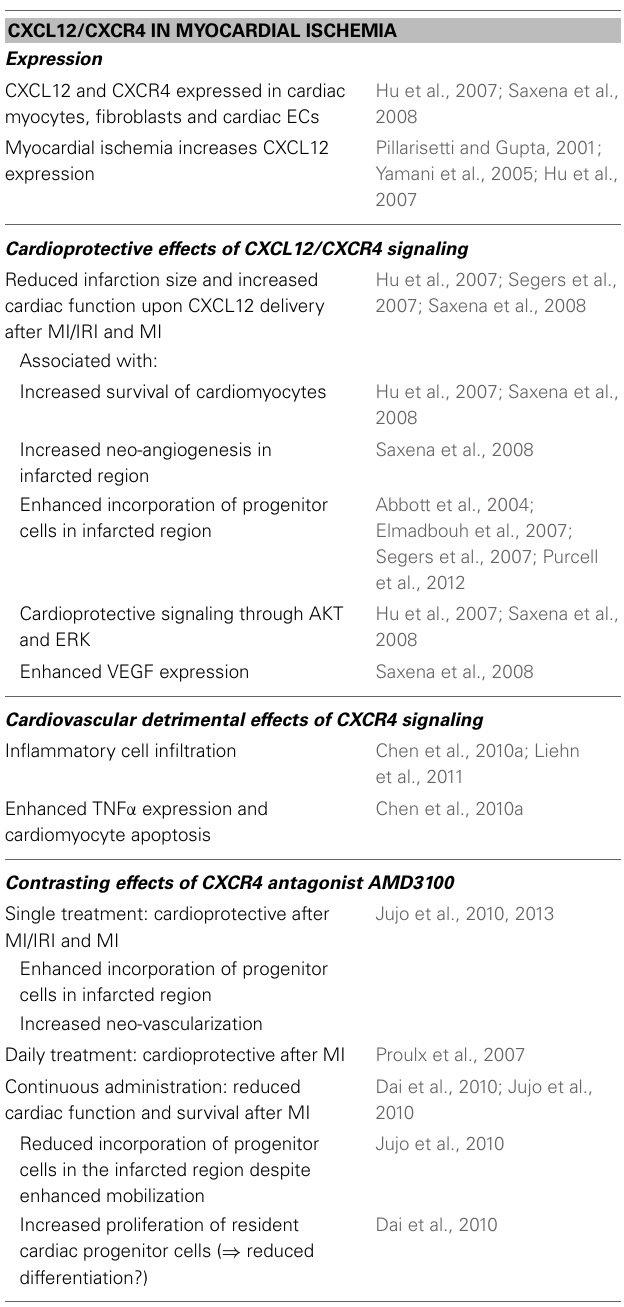
Table 1 | The CXCL12/CXCR4 axis in